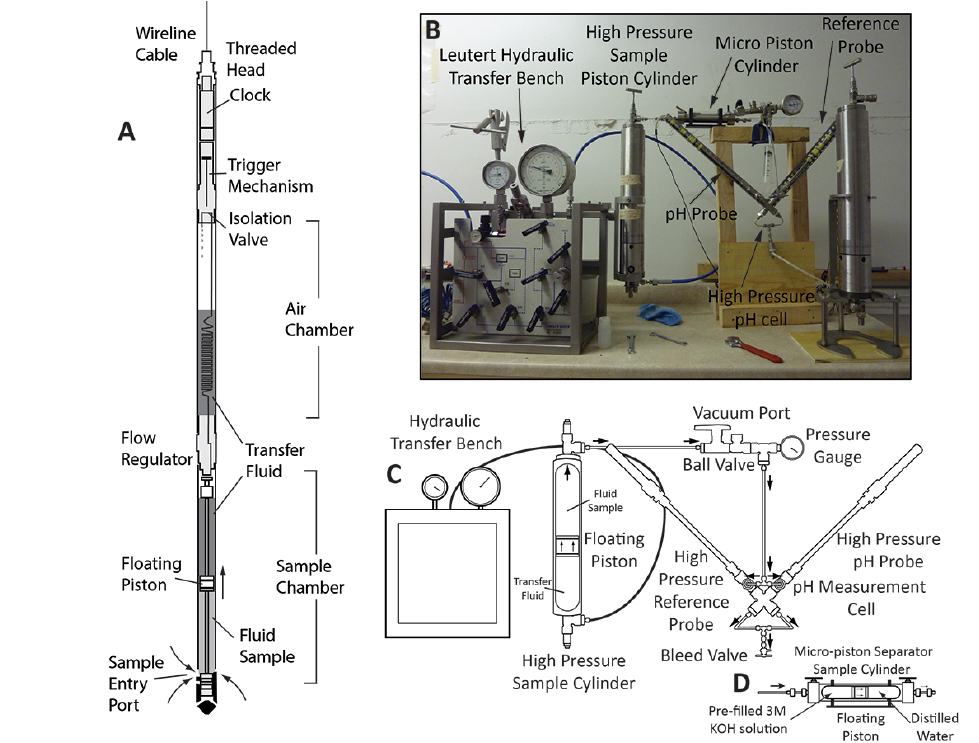
Figure 4. (A) Leutert Bottom Hole Positive Displacement Sampler (PDS sampler). (B) Laboratory set-up for extraction of high pressure fluid samples from the downhole fluid sampler for analysis of fluid CO 2 content and pH, in the field. (C) Showns the set-up for analysis of pH on pressurized samples. (D) The micro-piston cylinder used for the “alkalinity capture” of the dissolved CO 2